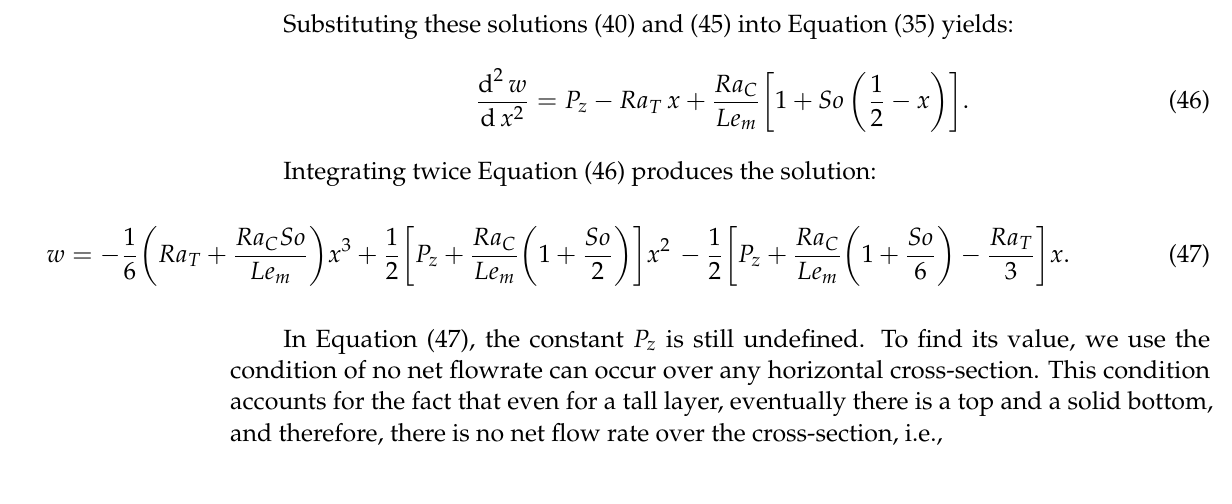
Figure 2. Graphical profile of the solution for ( a ) the basic temperature and ( b ) the basic mass fraction.